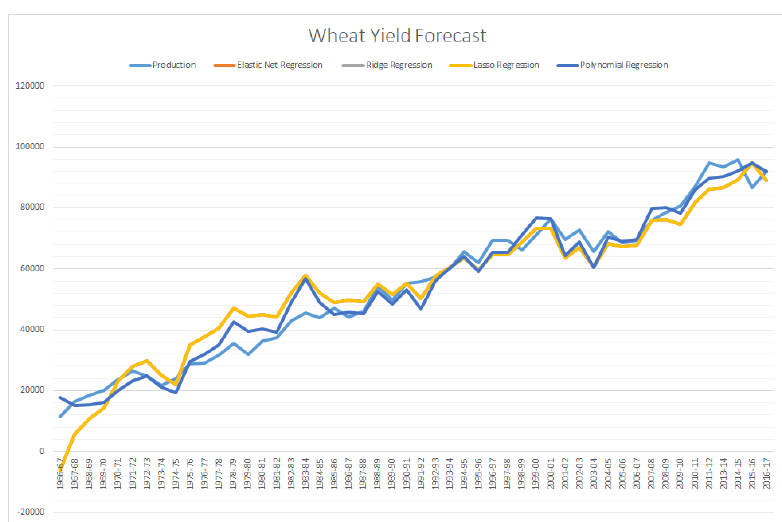
Figure 6: Forecasting using Various Regression